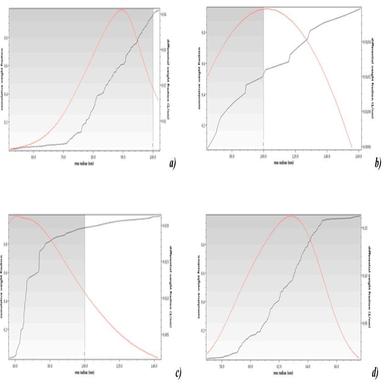
Cumulative and differential AF4-FFF-MALS analysis of PPPs: a) CS; b) EC; c) OD; d) WP.